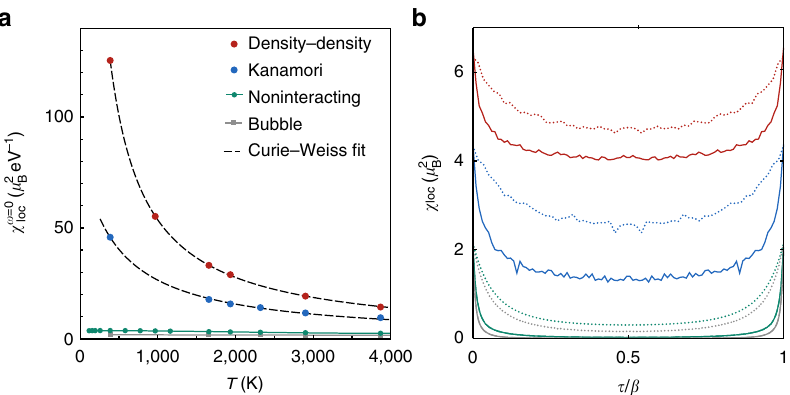
T Þ ¼ loc ð T Þ in iron displays a marked loc ð